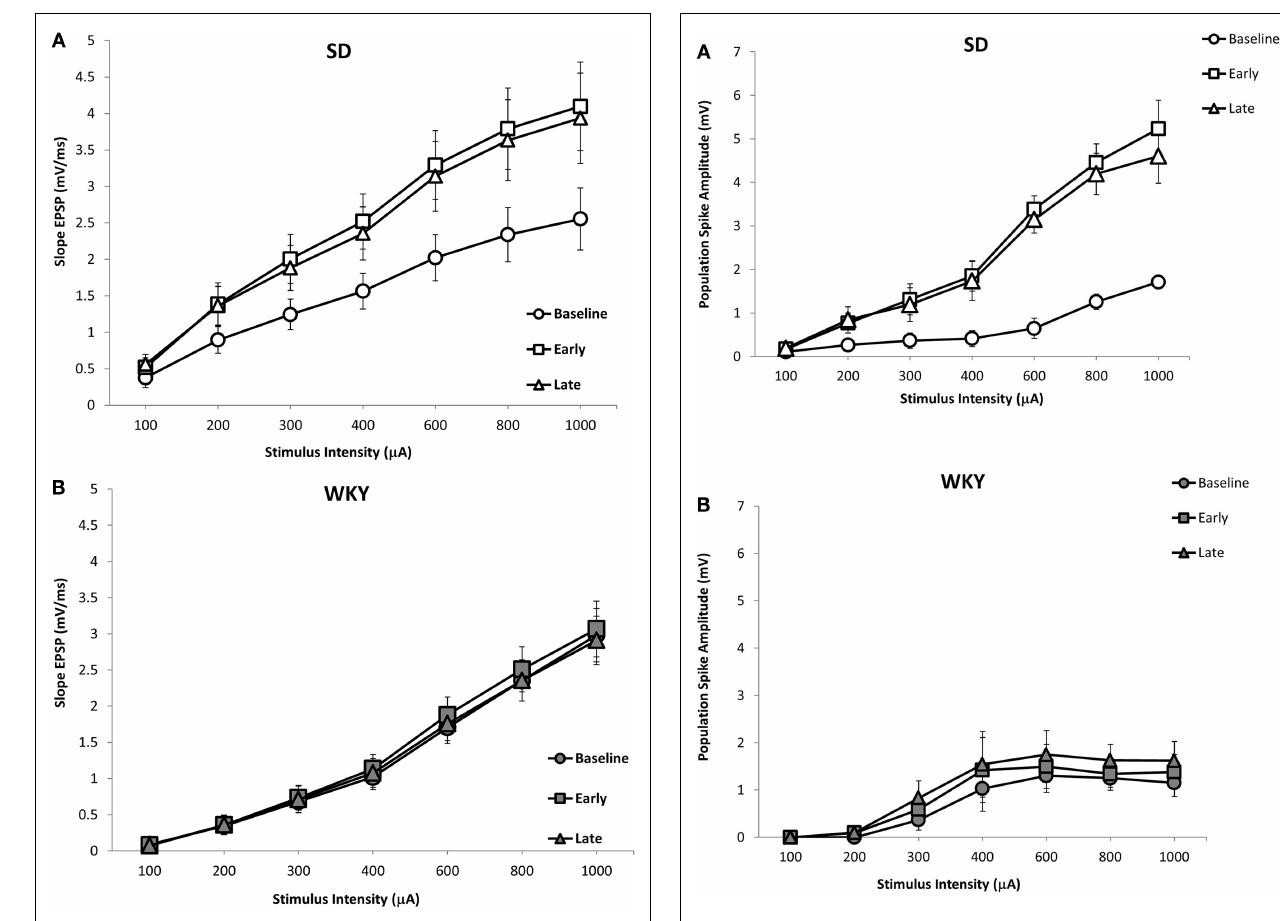
FIGURE 6 | LTP of the dentate gyrus field EPSP (fEPSP) following HFS of the medial perforant pathway in SD andWKY rats . SD rats exhibited early and late phase LTP of the fEPSP (A) . In contrast,WKY rats did not demonstrate LTP at either early or late time points (B) . Displayed are input–output (i/o) curves showing the baseline response, early phase LTP and late phase LTP. Shown are an average of two i/o curves generated prior to HFS (baseline), an average of i/o curves generated 15-min and 1-h after HFS (early), and an average of i/o curves generated 2- and 3-h after HFS (late).